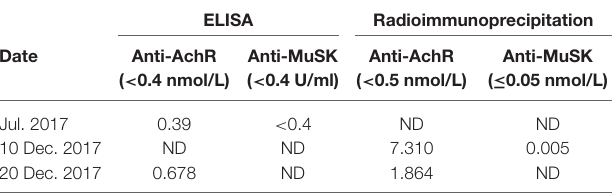
TABLE 2 | Titers of anti-AChR and anti-MuSK antibodies assayed by ELISA or radioimmunoprecipitation assay.